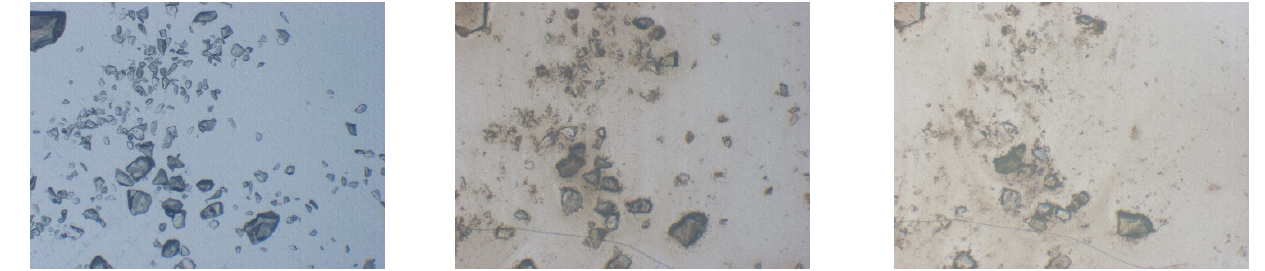
Figure 10. Optical images (40 × magnification) of ASD particles (produced by HME) immersed into water media at room temperature: after 1 min ( left ), 30 min ( middle ) and 60 min ( right